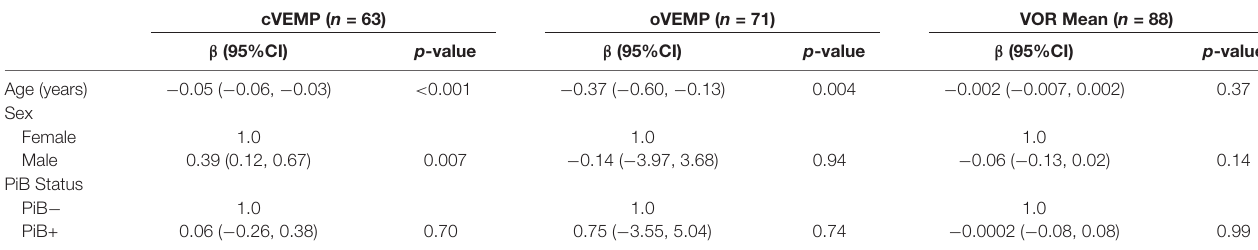
TABLE 2 | Cross-sectional analysis of PiB status and Vestibular Physiologic